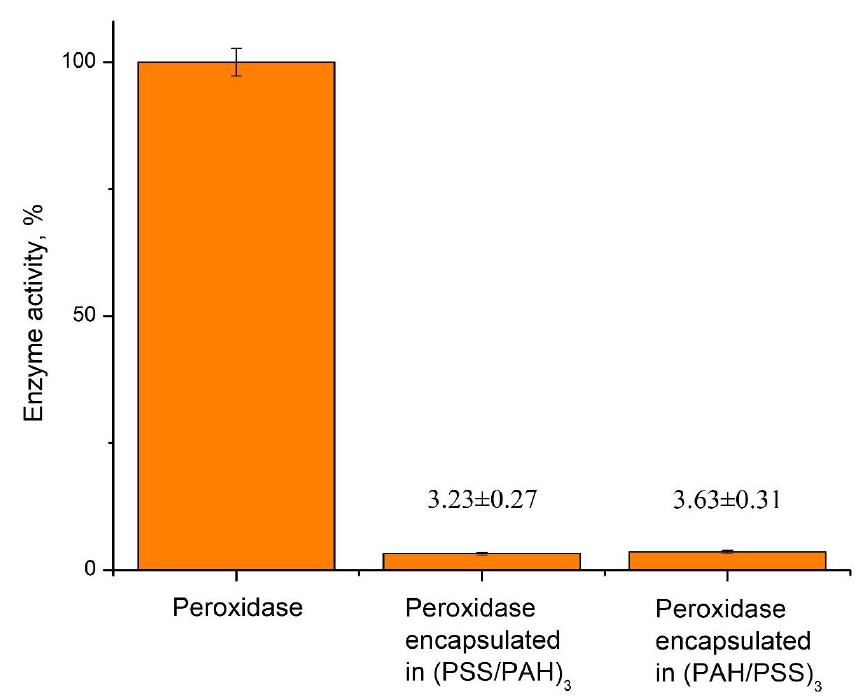
Figure 2. Activity of native and encapsulated peroxidase with different shell composition.